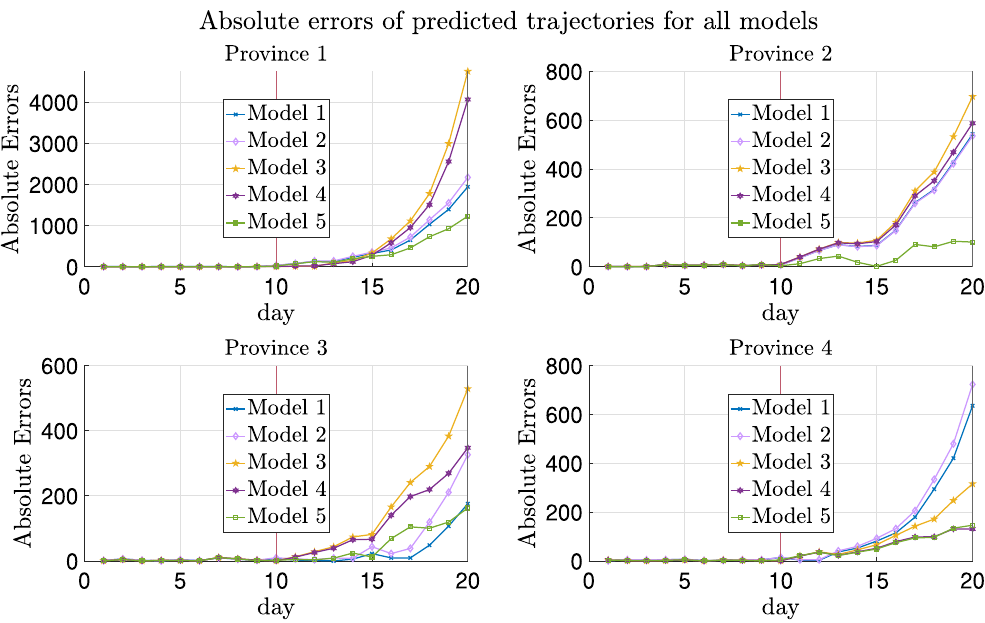
Figure 3. Absolute errors of fitted trajectories of Models 1–5 for the simulated data with four provinces. The vertical lines show the threshold of training-testing split.